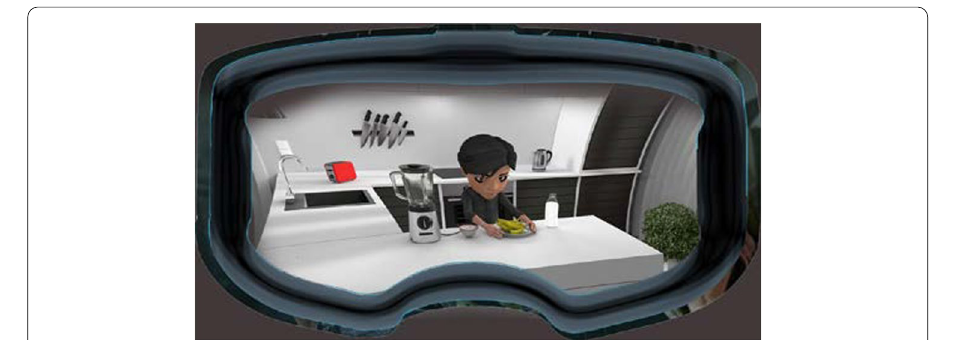
Fig. 4 An image of the VR app